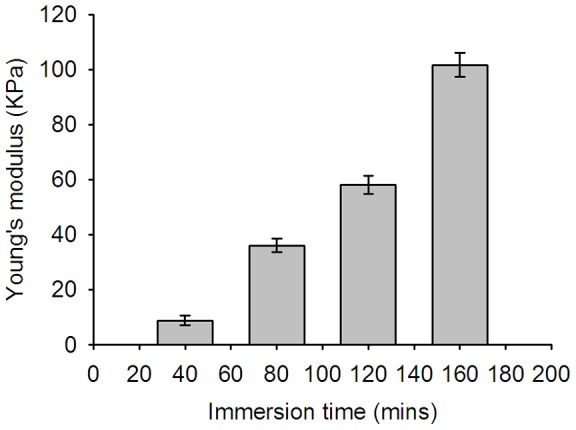
Average Young's modulus as a function of the immersion time. This result indicates a successful induction of cataract lens.